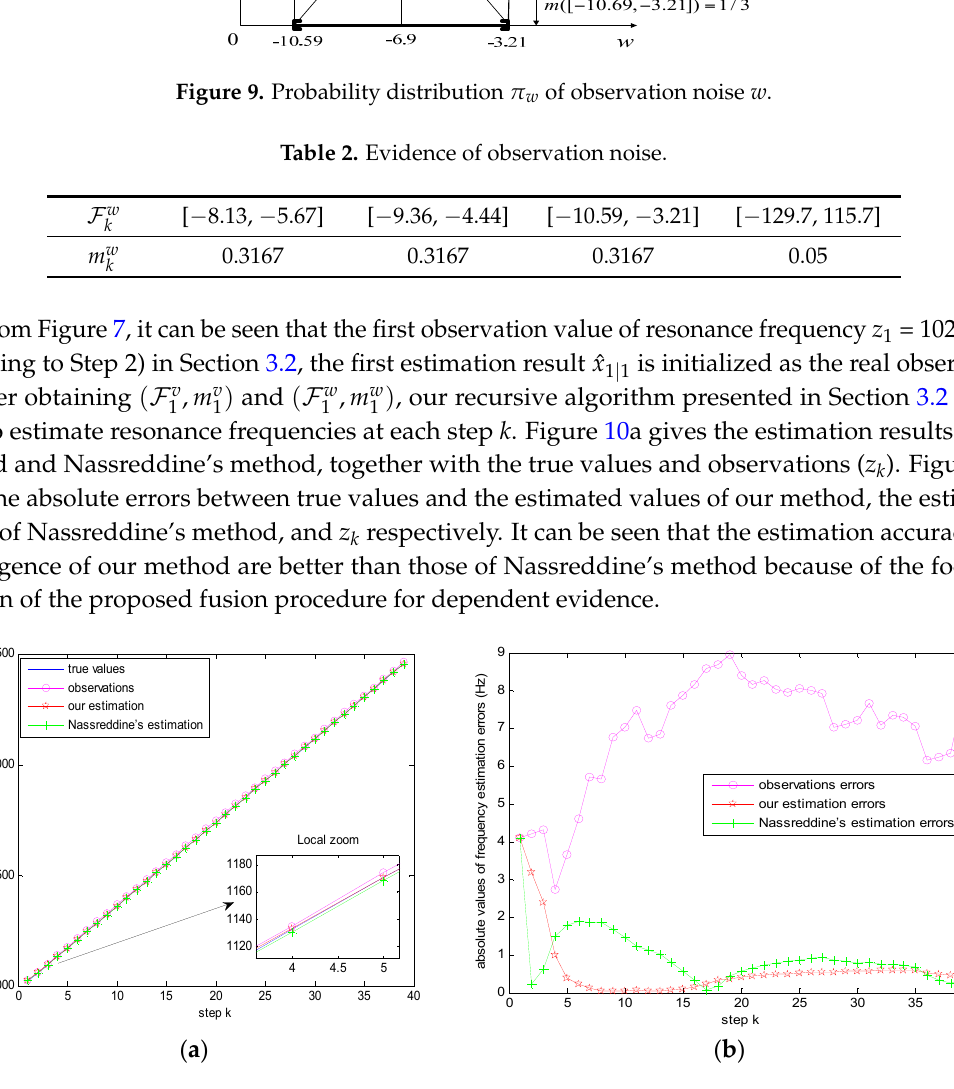
Figure 10. ( a ) Estimation results of resonance frequencies, ( b ) Absolute values of frequency estimation errors.